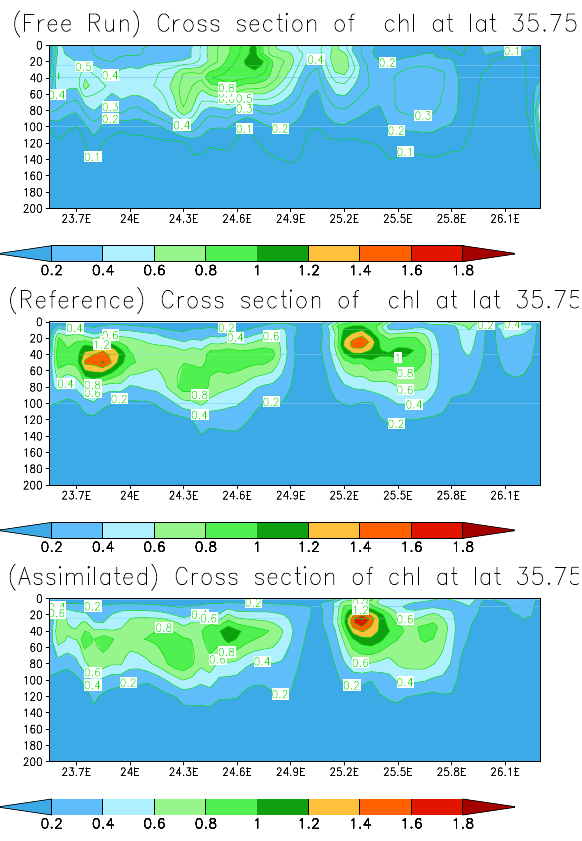
Fig. 11. Vertical cross sections of chlorophyll concentrations (mg/m 3 ) at latitude 35 . 75 ◦ E from the free run, the reference run, as estimated by the SEPLEK filter.